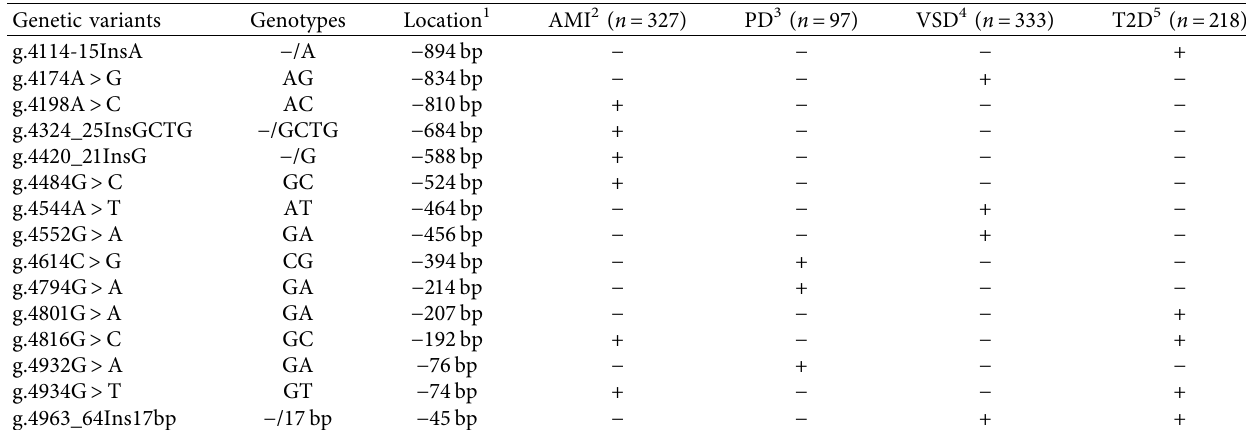
Table 4: Summary of genetic variants within the SIRT1 gene promoters in human diseases. Genetic